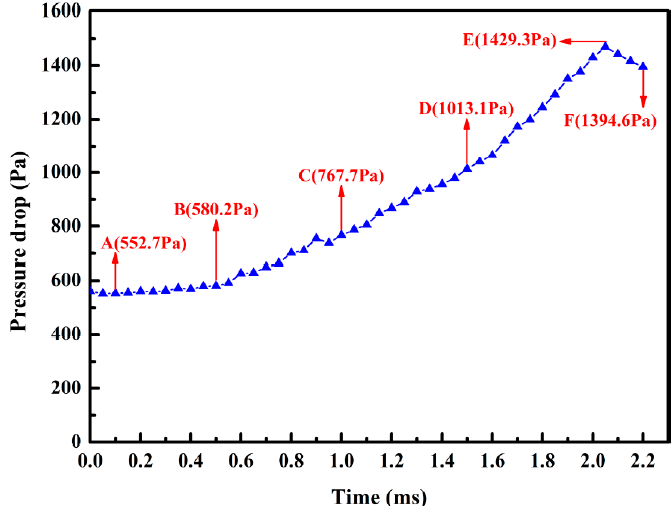
Figure 5. Pressure drop curve with time.